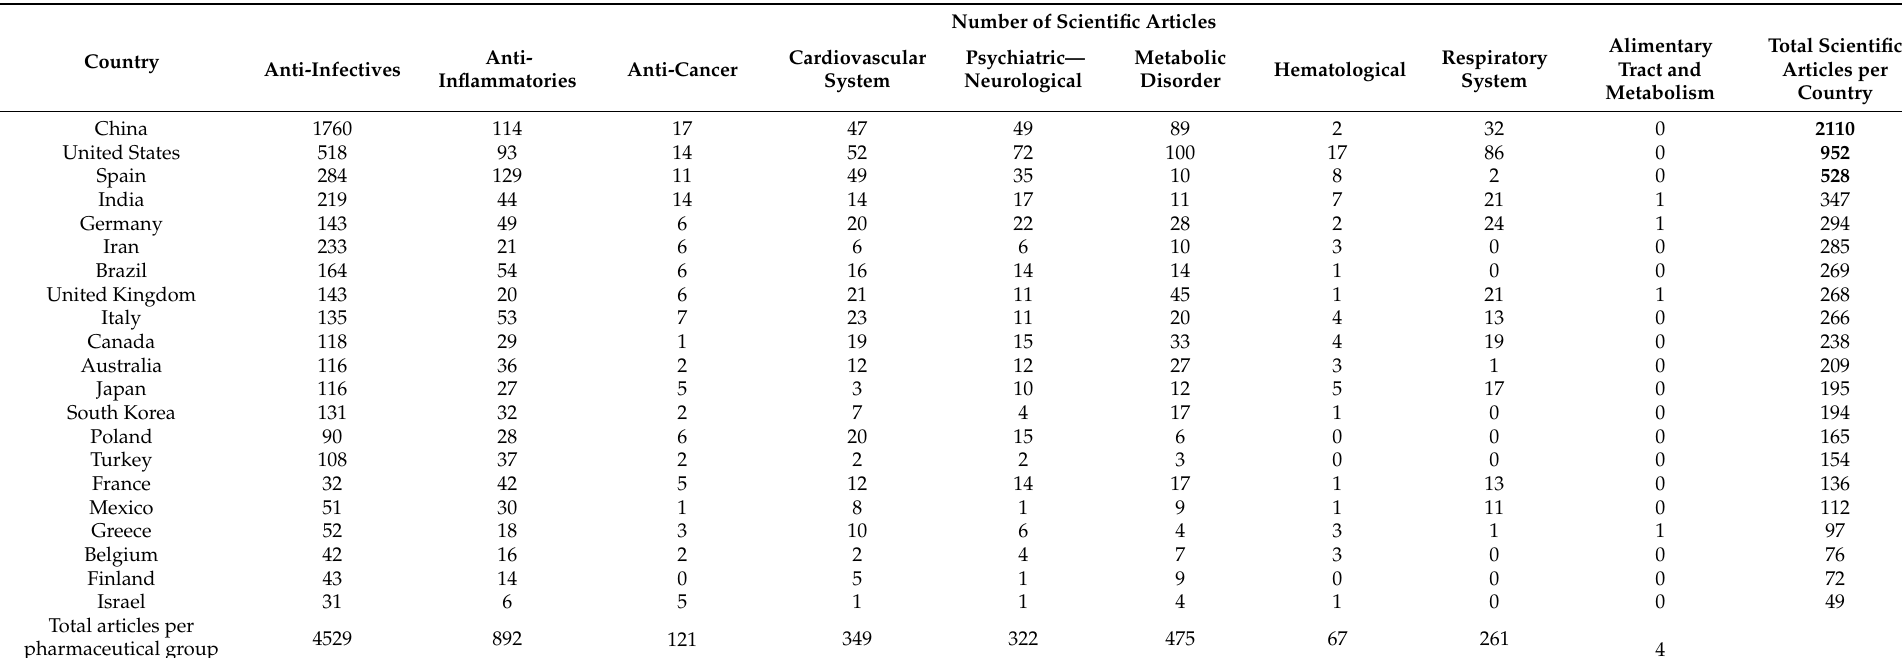
Table 4. Number of scientific articles wrote by the leading countries throughout the world regarding wastewater treatment of each pharmaceutical group between 1998 to 2020 in Scopus using wastewater or water as keywords and English as a language